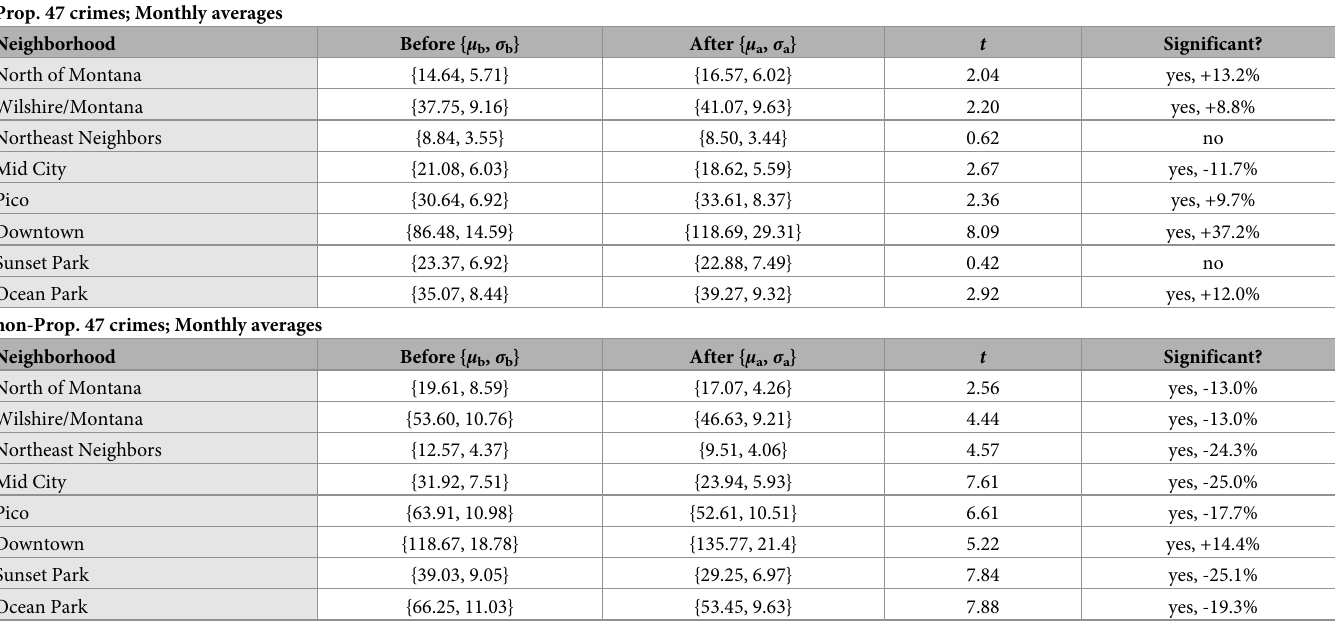
Table 2. Statistical tests on reported crime in neighborhoods of Santa Monica, CA, 2006–2019, before and after the passage of Prop. 47. Prop. 47 crimes; Monthly averages